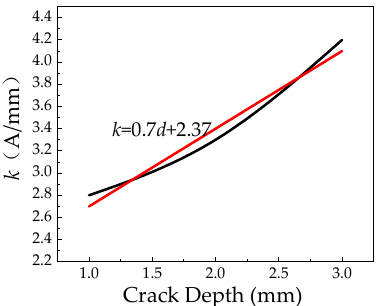
Figure 18. Relationship between the internal pressure increasing factor k and the crack depth.